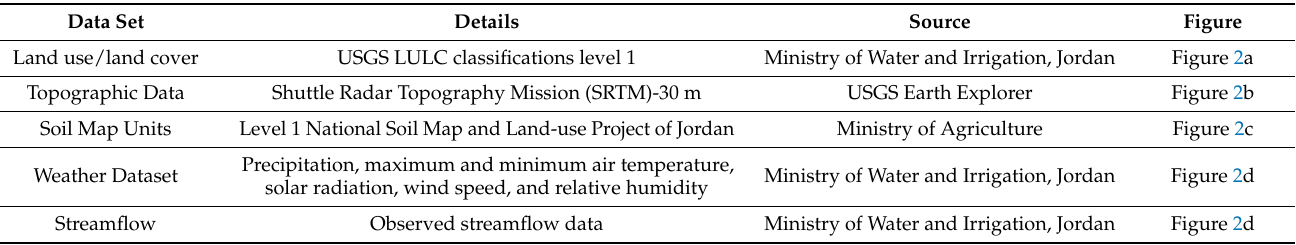
Table 1. Data sets used to develop SWAT Model.